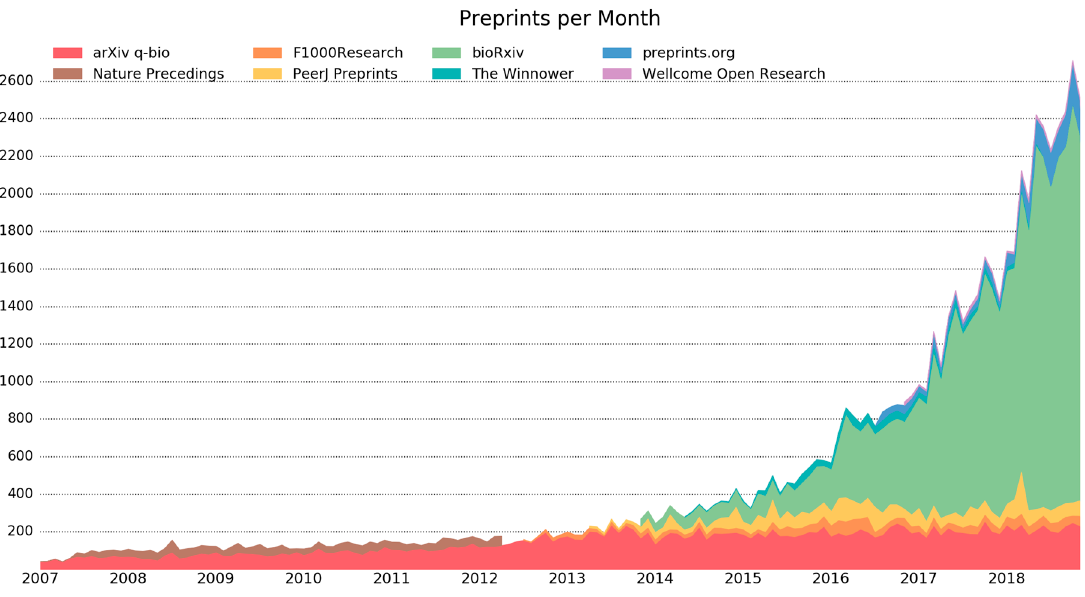
Figure 1. Monthly preprints added in November 2018 is 2509. Source: PrePubMed.org.